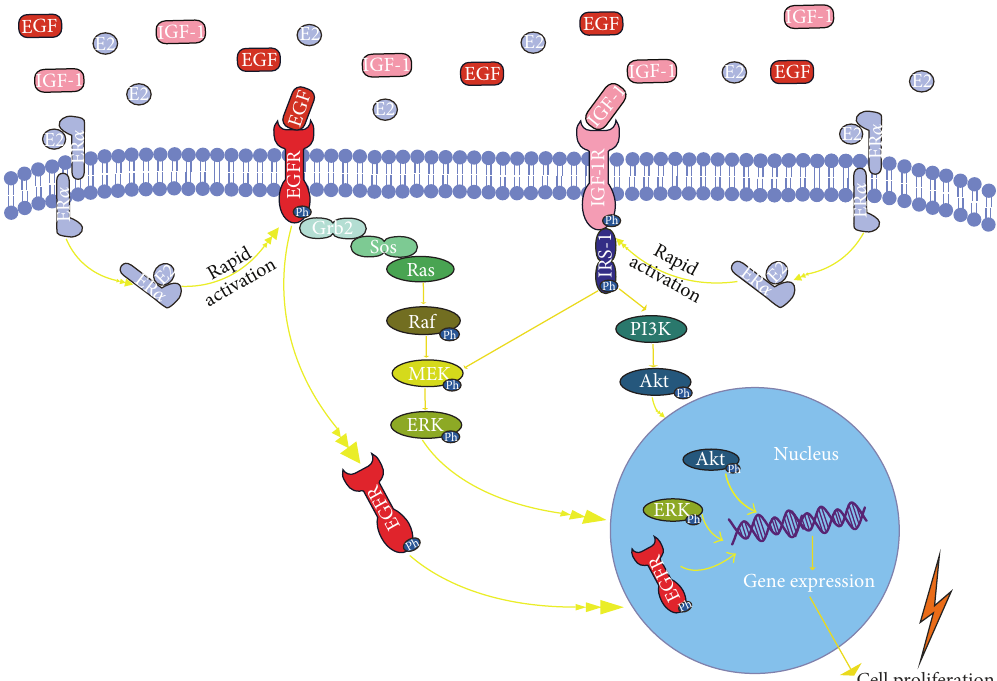
Figure 1: Schematic representation of IGF/EGF signaling, crosstalk with ERs. IGF-I binding to IGF-IR results in its activation and the consequent activation of PI-3K and ERK mediators. EGF-induced activation of EGFR activates the ERK and may lead to gene expression of proliferative genes via internalization of activated EGFR to nucleus. E2-ER 𝛼 binding leads to rapid activation of EGFR and/or IGF-IR. The activation of IGF/EGF signaling pathways stimulates cell